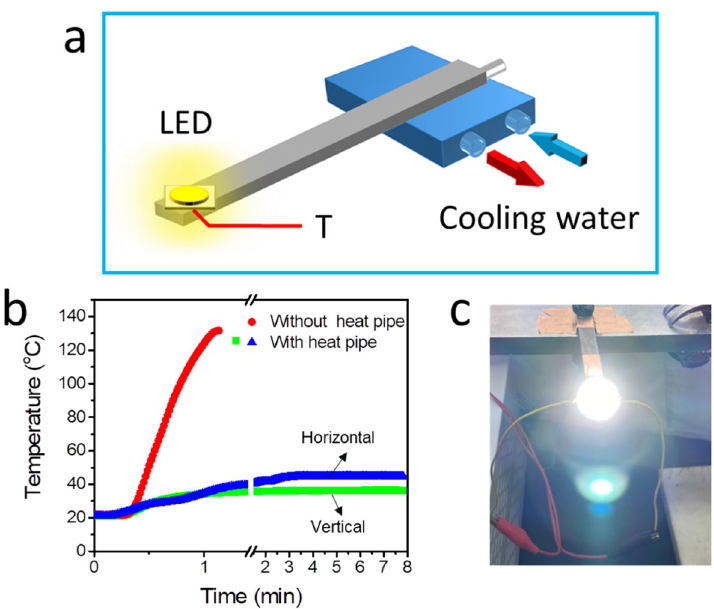
Figure 4. Thermal management of an LED by using the 3D-printed flat heat pipe: ( a ) schematics of the experimental setup; ( b ) temperature evolution of the LED (over time); ( c ) a photograph showing that the LED can light up with the assistance of the heat